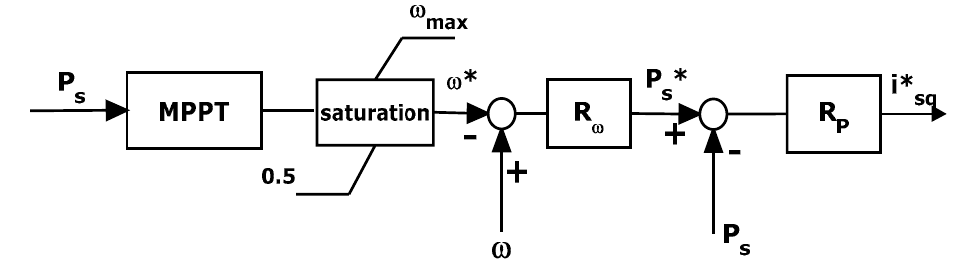
Figure 4. Voltage regulator block diagram. MIN: minimum.